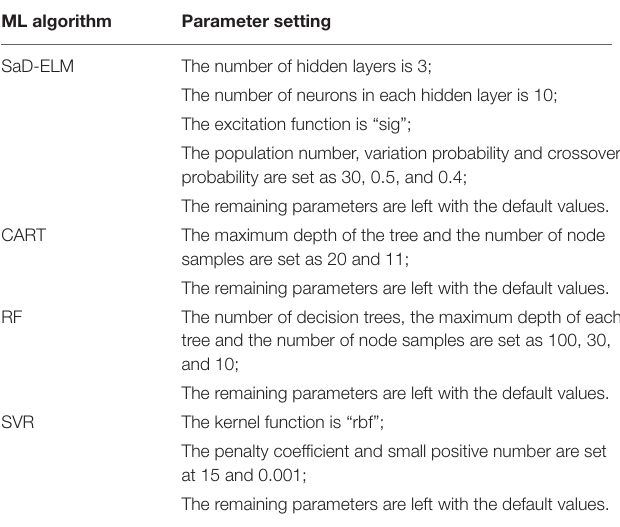
TABLE 3 | Parameter setting of four ML algorithms. ML algorithm Parameter setting SaD-ELM